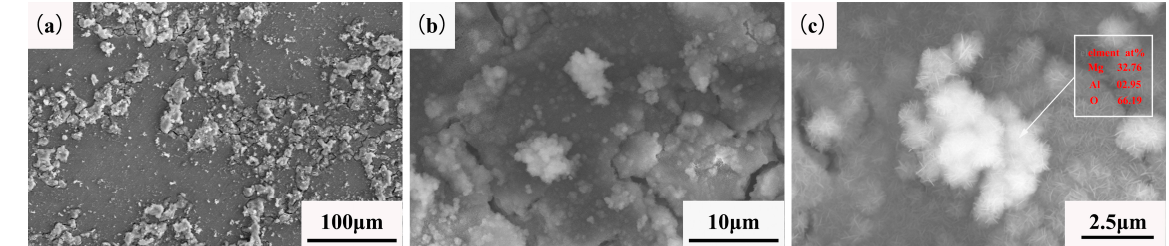
Figure 9. ( a ) Corrosion morphology of ZAT543 alloy immersed in 3.5 wt% NaCl for 1 h; ( b ) high-magnification corrosion morphology; ( c ) corrosion products of ZAT543 alloy.